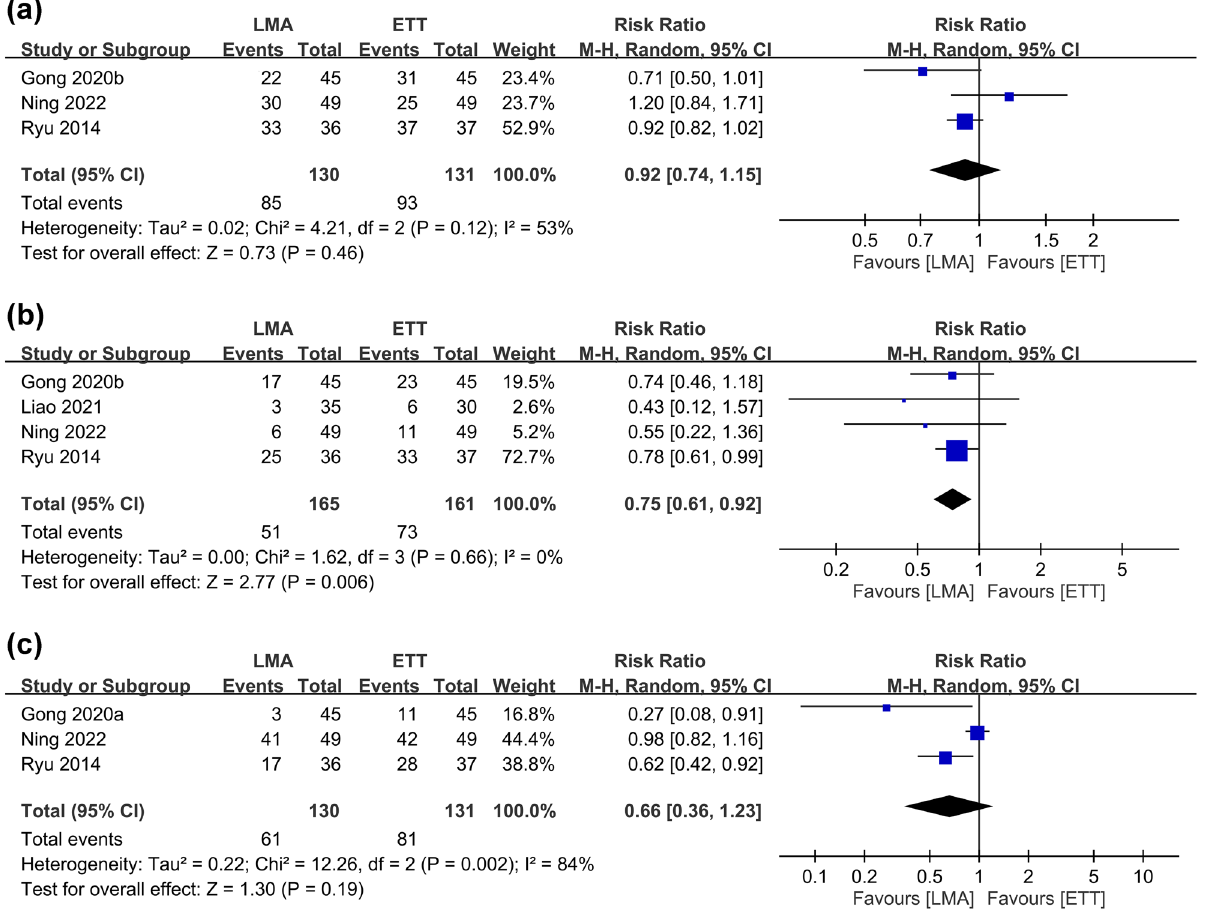
Figure 3. Forest plot comparing the risk of postoperative sore throat at ( a ) 1 h, ( b ) 24 h, and ( c ) 48 h between laryngeal mask airway (LMA) and endotracheal tube (ETT) groups. CI confidence interval, M–H Mantel–